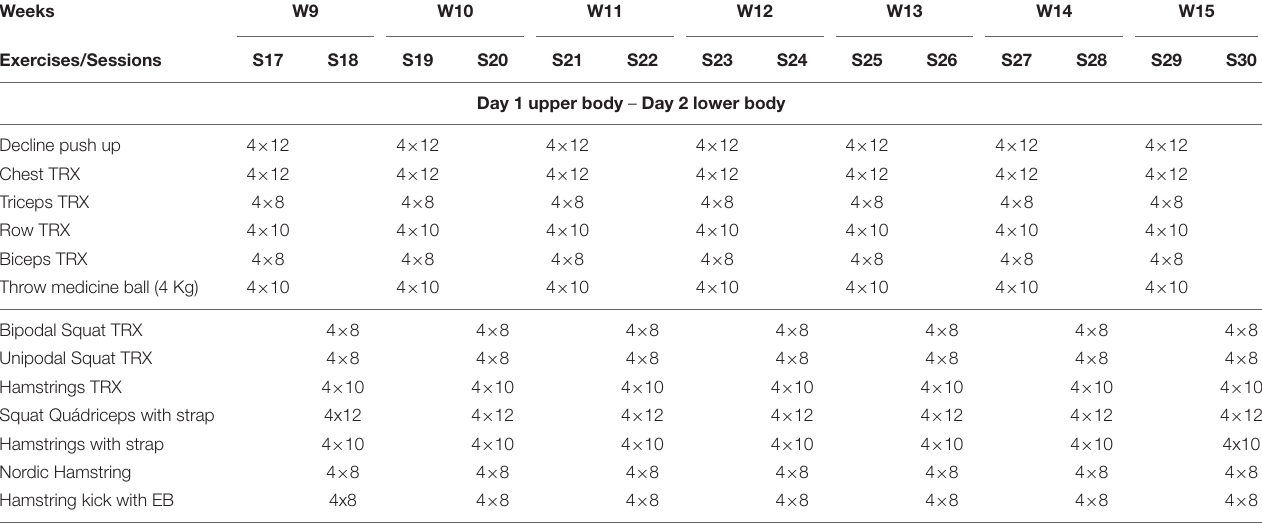
TABLE 1 | Phase 1(B): Self-load